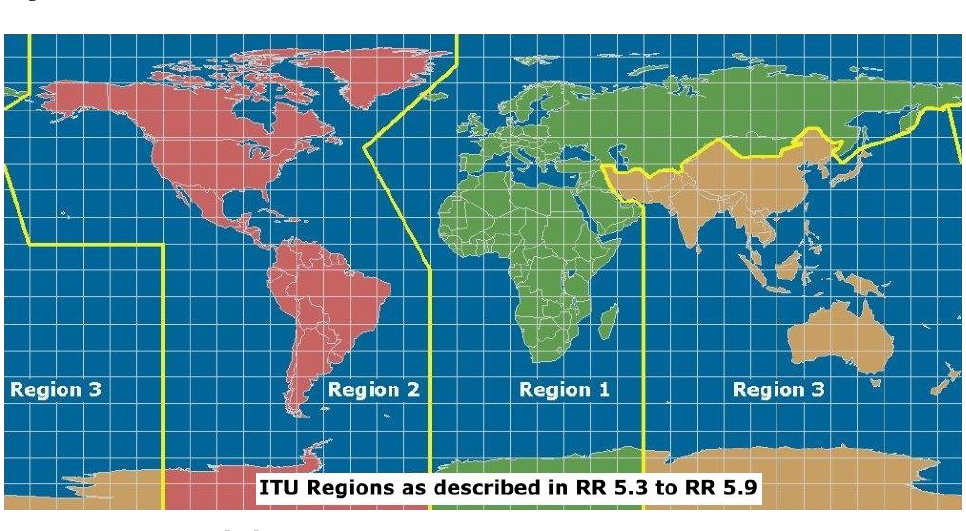
Figure 3. ITU regions